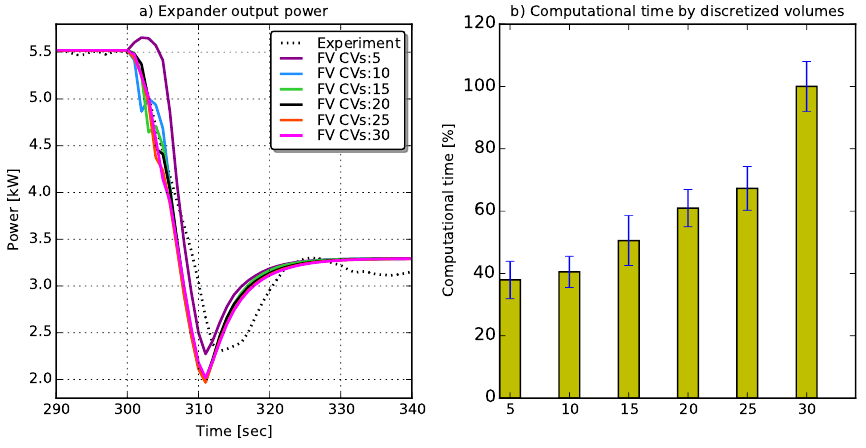
Figure 6. Results of the number of control volumes (CVs) parametric analysis for the FV evaporator model. ( a ) Expander output power as predicted by the finite volume model for different discretization levels. ( b ) Computational time for the different discretization